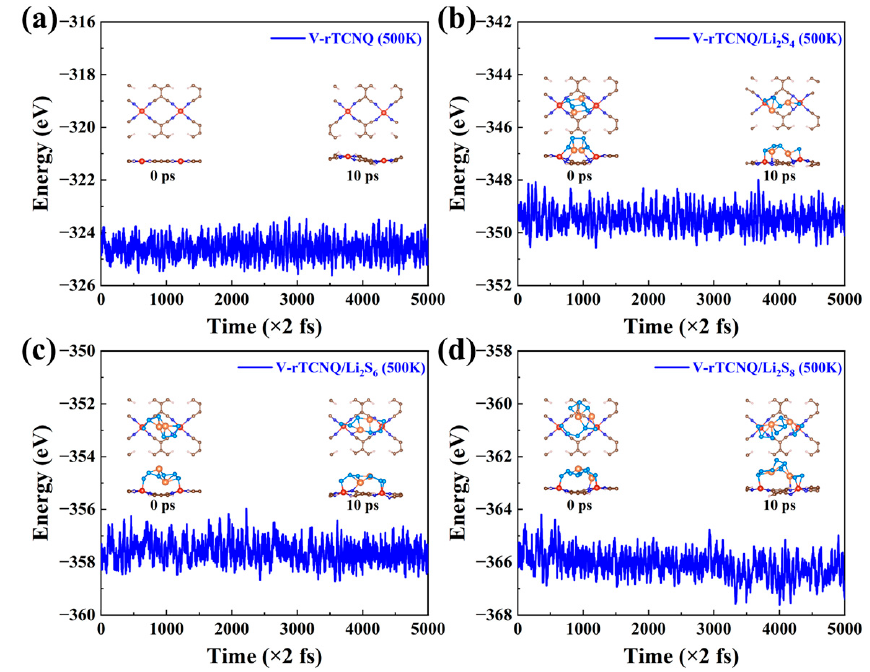
Figure 5. The AIMD simulation results of the V-rTCNQ structure ( a ) and adsorption systems of V-rTCNQ/Li 2 S 4 ( b ), V-rTCNQ/Li 2 S 6 ( c ), V-rTCNQ/Li 2 S 8 ( d ) at 500 K and 10 ps.